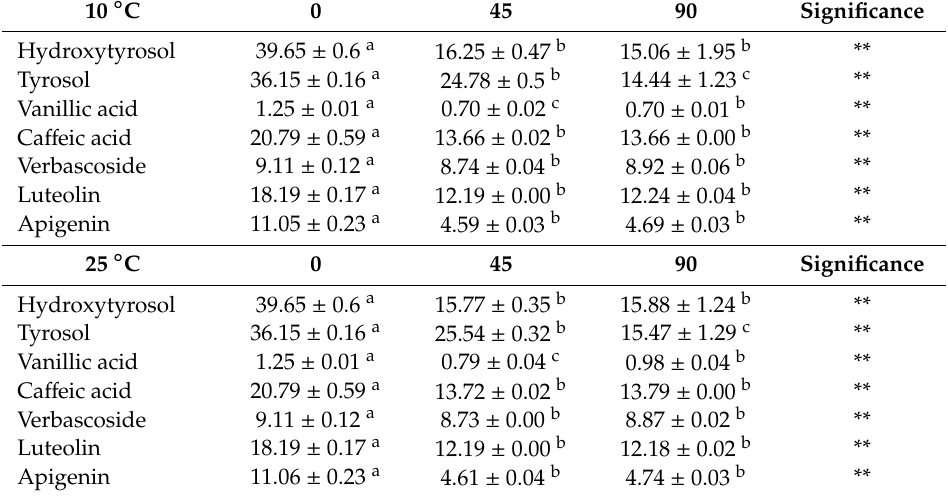
Table 4. Phenolic compounds (mg kg − 1 of sample) in Mboil during the storage (days) at 10 and 25 ◦ C. letters and ** see Table